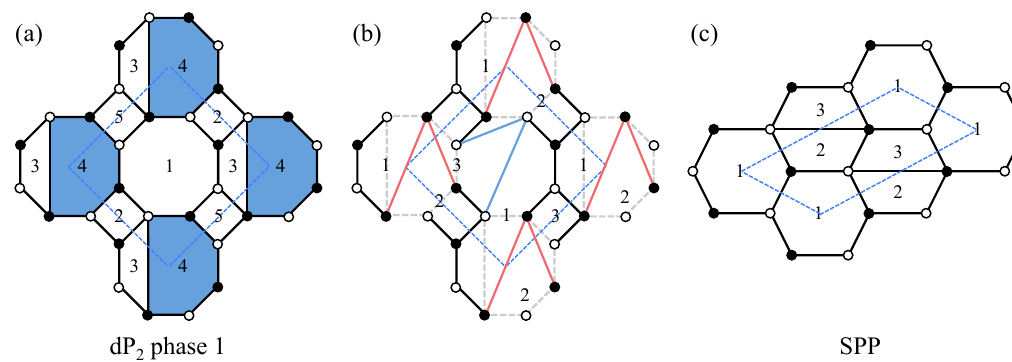
Figure 40. Instanton backreaction from phase 1 of dP 2 to SPP.